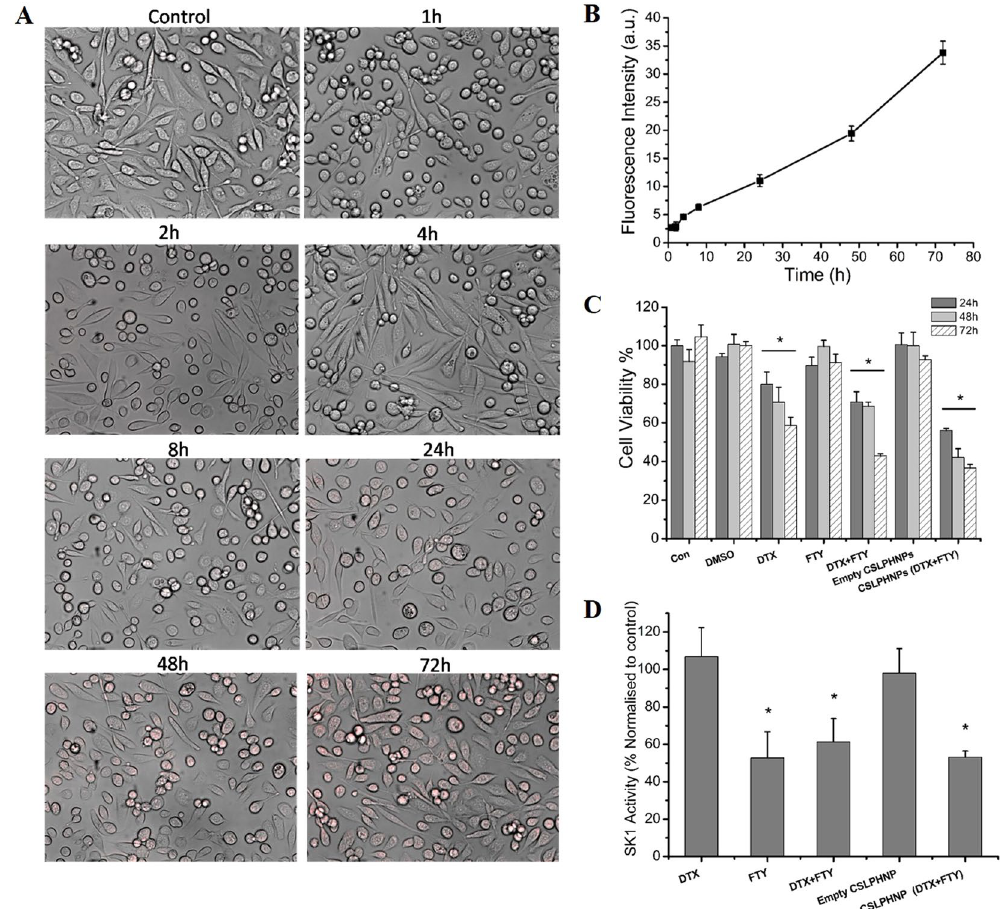
Figure 3. In vitro assessment of CSLPHNPs. Hormone-refractory metastatic prostate cancer PC-3 cells were treated with free drugs or CSLPHNPs for 72 hours. ( A ) Fluorescent/phase contrast images of PC-3 cells after incubation with CSLPHNPs containing Rhodamine B. ( B ) CSLPHNPs uptake assessed by fluorescent microscopy ( A ) was quantified by ImageJ. ( C ) Cytotoxicity of CSLPHNPs was assessed using the MTT assay. Columns, mean of three experiments performed in triplicate. Data is expressed as mean (n = 3) ± SE. * p < 0.05 versus control. D) PC-3 cells were treated for 48 h as indicated in figure and SK1 activity was measured by radiolabeling. Data is expressed as percentage relative to the control. Columns represent the mean of n = 3 ± SE. * p < 0.05 versus